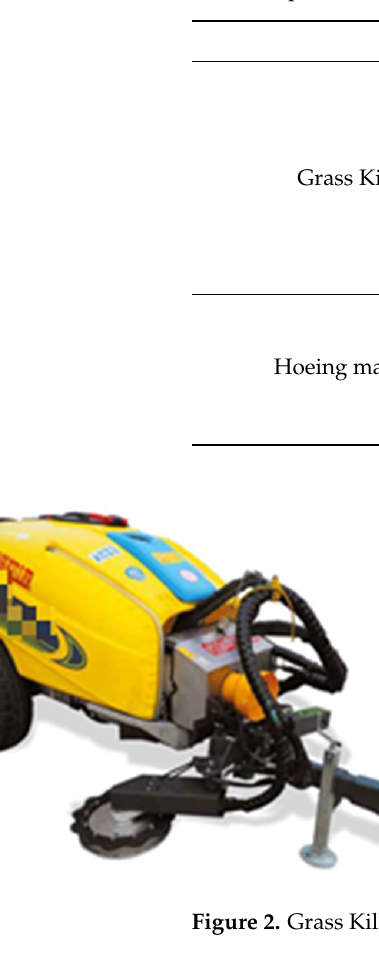
Table 1. Specifications of the machines adopted used in the field tests.